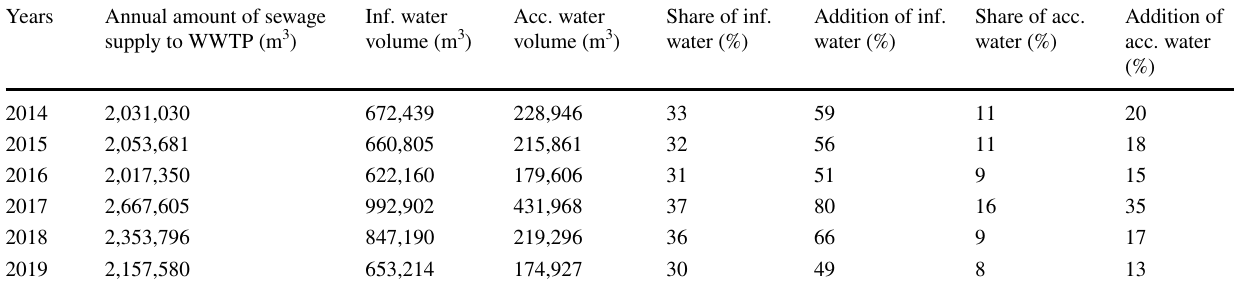
Table 2 Share, additions, and annual volumes of extraneous water in the considered catchment in 2014–2019, calculated by the triangle